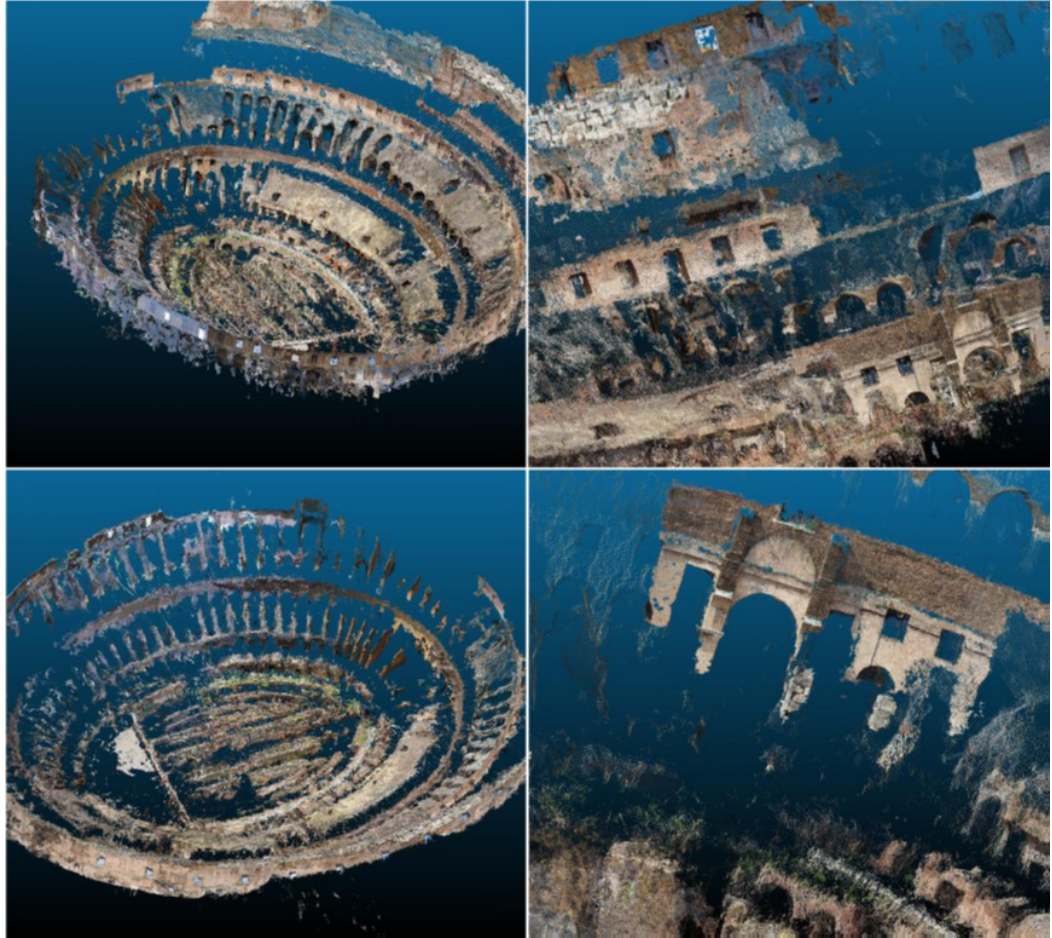
Figure 2. 3D reconstruction results of Colosseum taken from the FLICKR web image